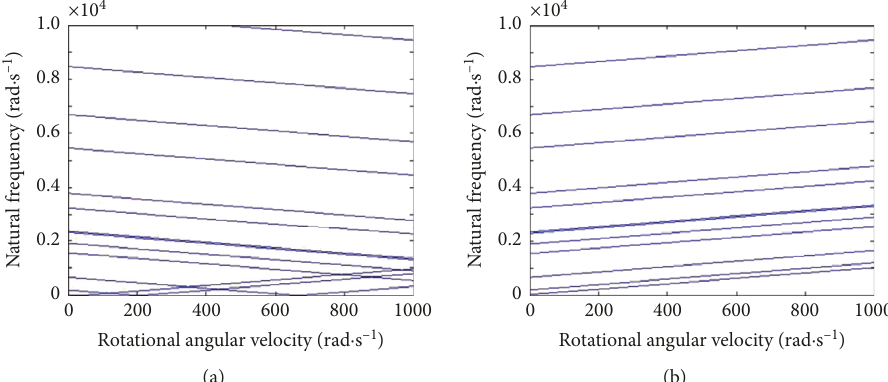
Figure 6: Coupled natural frequency of transverse vibration of the disk: (a) forward processional modes and (b) backward processional